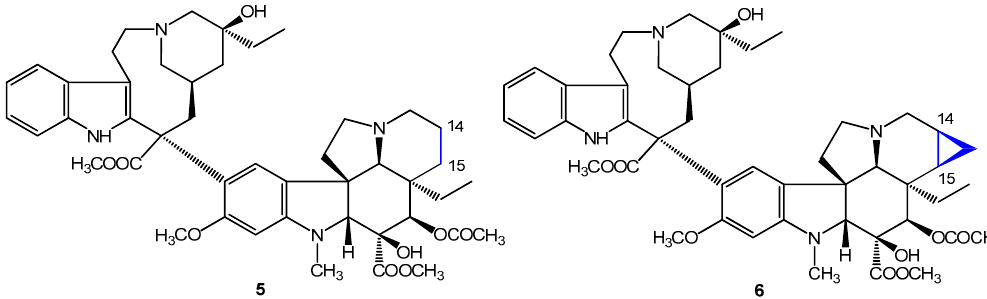
Figure 2. The alkaloids 14,15-dihydrovinblastine ( 5 ) and 14,15-cyclopropanovinblastine ( 6 ).